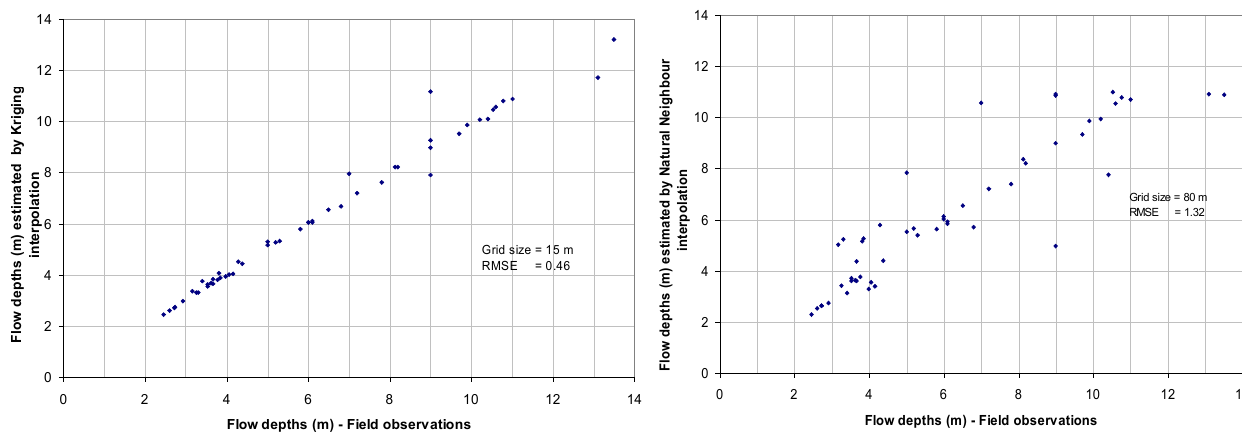
Flow depths (m) - Field observations